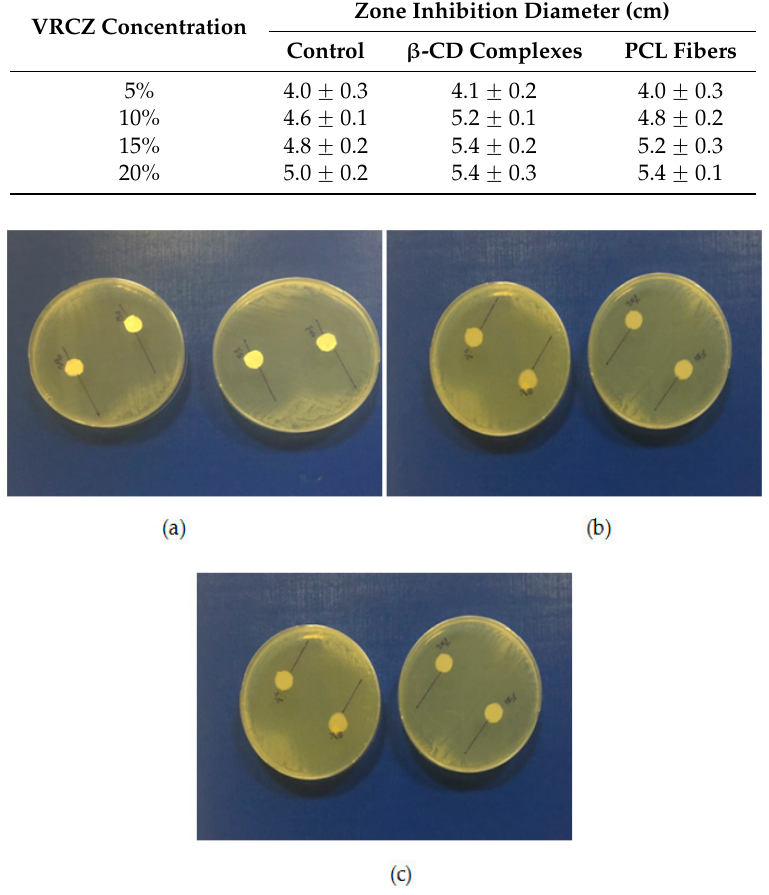
Figure 10. Antifungal activity ( a ) PCL fibers containing VRCZ; ( b ) VRCZ inclusion complexes; and ( c ) VRCZ solution.